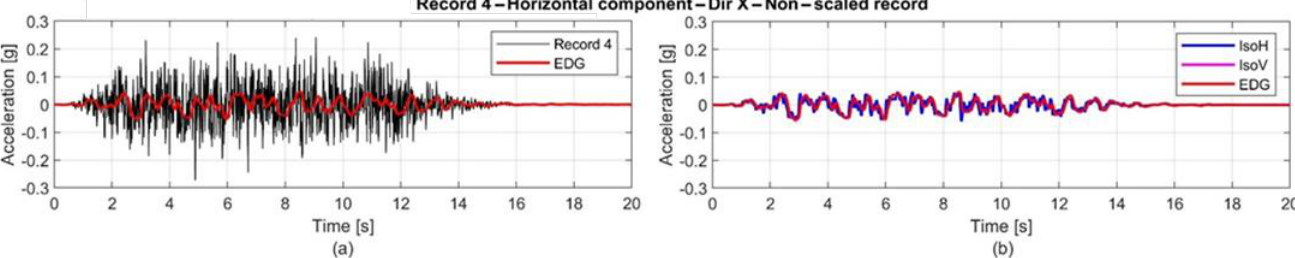
Figure 4. Horizontal acceleration time history results for non-scaled Record 4—direction “X”. ( a ) Record and EDG response comparison; ( b ) System response by isolation level.